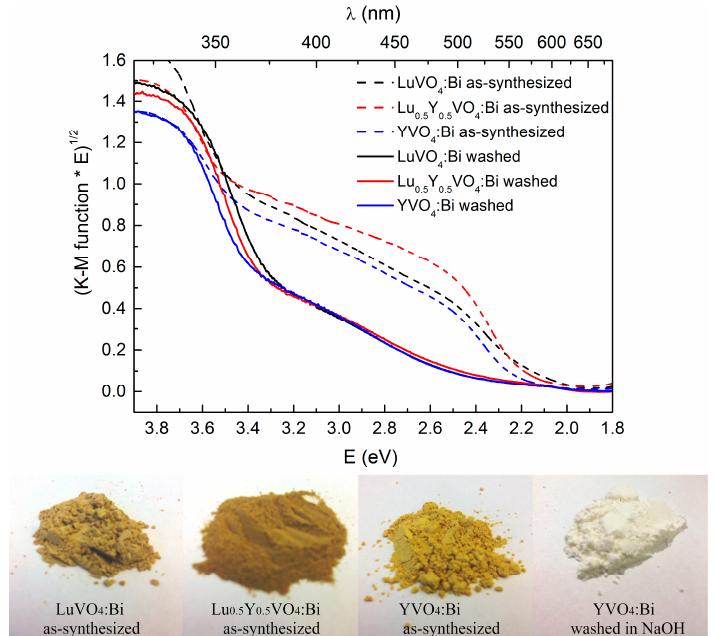
Figure 7. Comparison of the optical absorption spectra and color of YVO 4 :Bi, Y 0.5 Lu 0.5 VO 4 :Bi and LuVO 4 :Bi samples, as-synthesized and washed in NaOH.